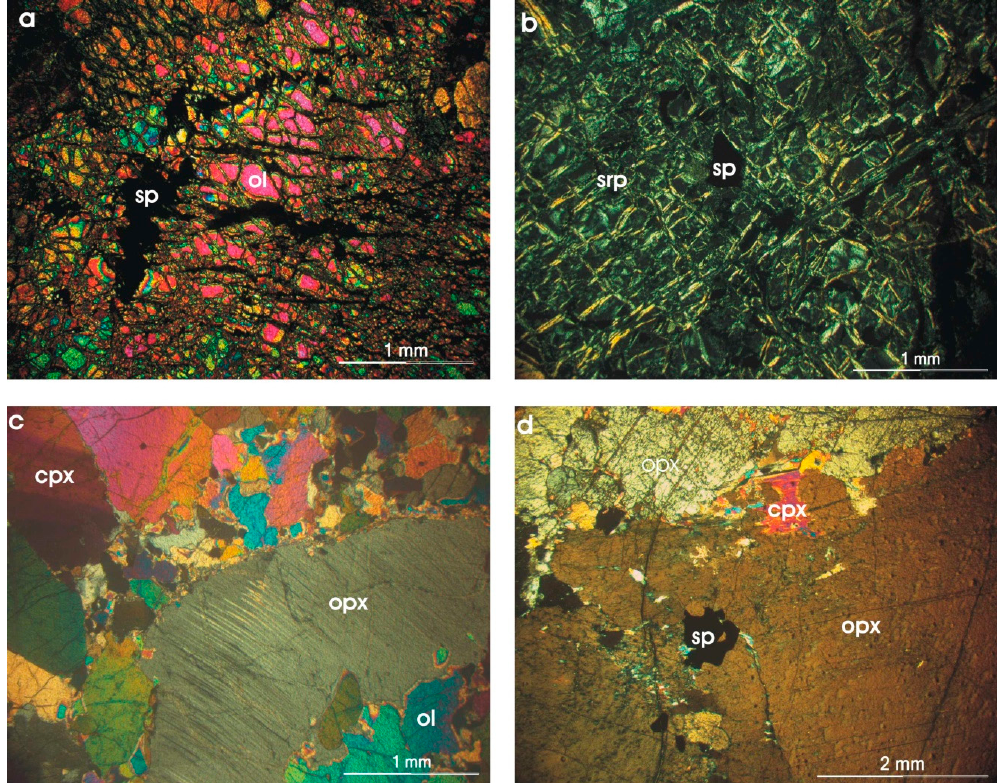
Figure 2. Photomicrographs of representative ultramafic aggregate rocks (XPL): ( a ) cataclastic olivine in a dunite (sample GE.34). ( b ) mesh serpentine and crystals of spinel in a serpentinized harzburgite (sample BE.01). ( c ) porphyroclasts of orthopyroxene showing kink banding, olivine, and